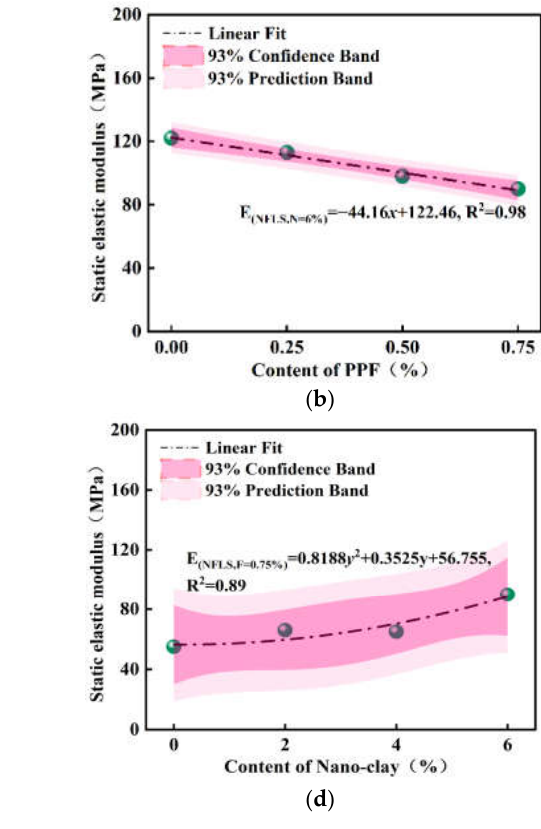
Figure 7. Static elastic modulus: ( a ) static elastic modulus curve of NLS; ( b ) static elastic modulus curve of NFLS (N = 6%); ( c ) static elastic modulus curve of FLS; ( d ) static elastic modulus curve of NFLS (F = 0.75%).